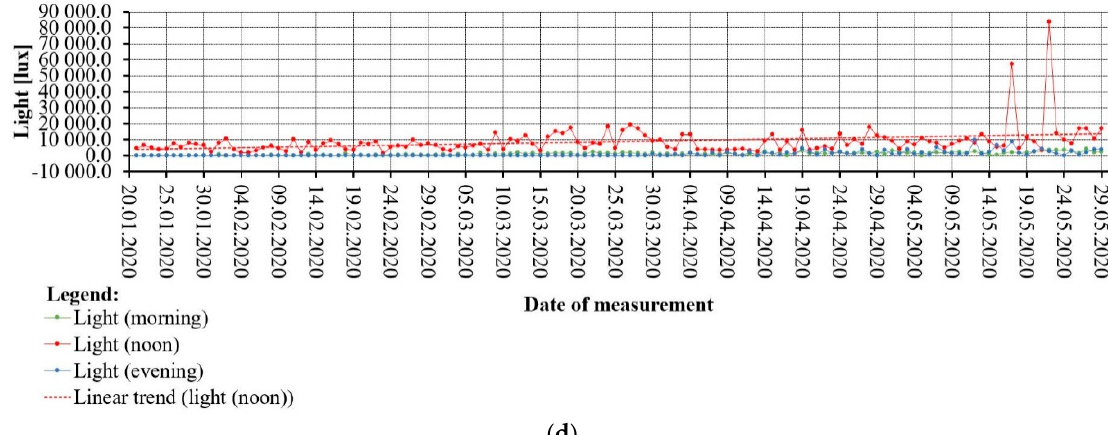
Figure 6. Graphical interpretation of the weather condition of the rail S49 (49E1): ( a ) temperature inside the crown of the rail, ( b ) ambient temperature, ( c ) humidity, ( d ) ambient light.